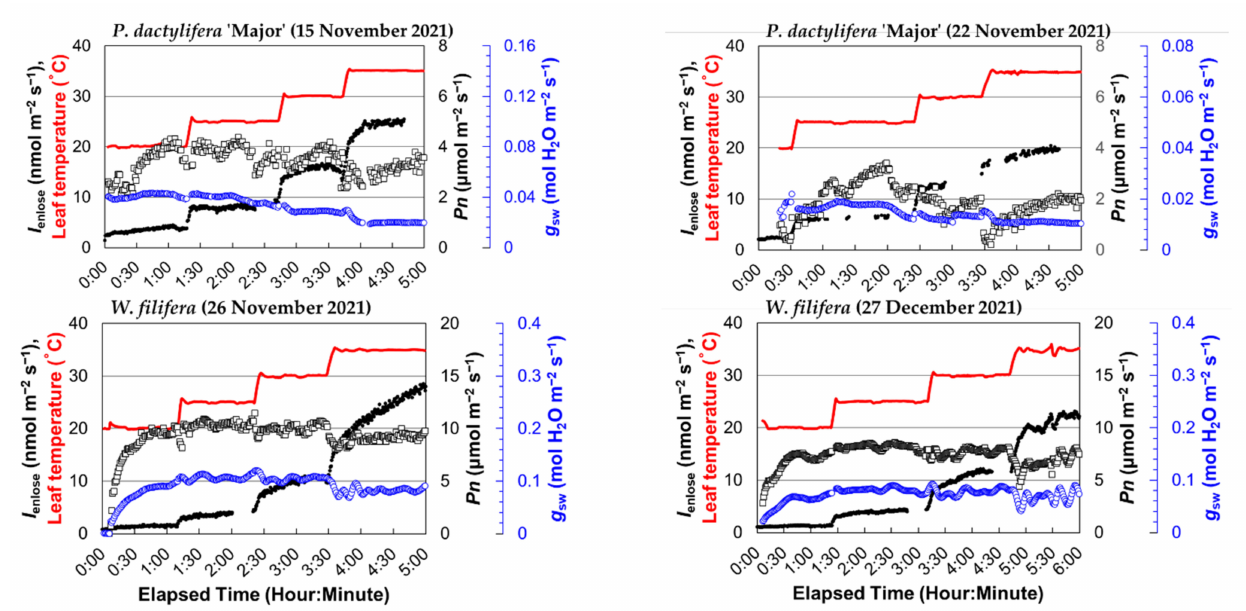
Figure 2. The time plot of the isoprene emission rate obtained by the enclosure method ( I enclose ), net photosynthetic rate ( Pn ), stomatal conductance ( g sw ), and leaf temperature for four palm species ( B. yatay , P. dactylifera ‘Piarom’, P. dactylifera ‘Major’, and W. filifera ). Solid dots: I enclose ; open squares: Pn ; blue-colored open circles: g sw ; red line: leaf